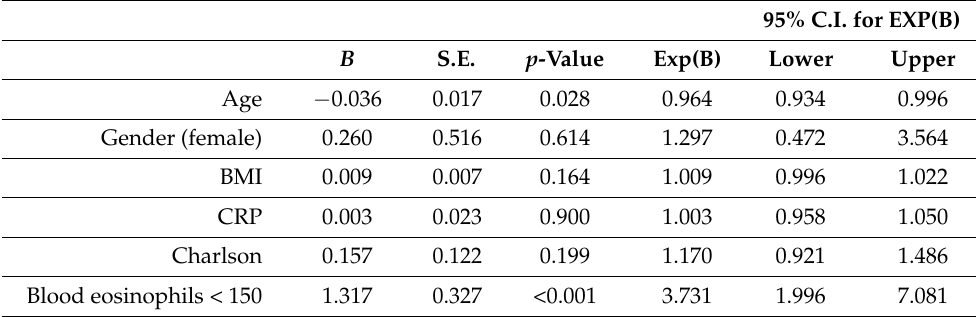
Table 3. Multinomial logistic regression analysis for the prediction of the need of NIV in COPD subjects admitted to hospital for COPD